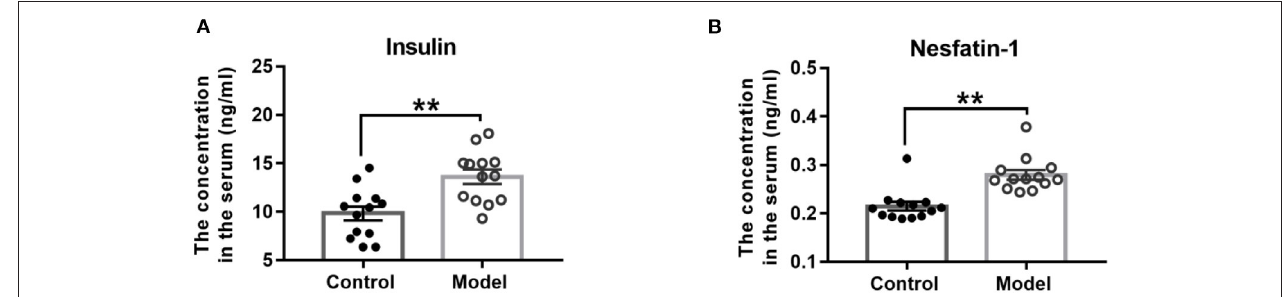
FIGURE 5 | Effect of bilaterally hippocampal injection of STZ on the serum concentrations of insulin and nesfatin-1. The data are presented as the mean ± SEM, with 13 mice in each group. Compared with those in the control mice, the serum concentrations of insulin (A) and nesfatin-1 (B) were observably increased in the bilaterally hippocampal STZ-injected mice. ** P < 0.01, compared with the control group.